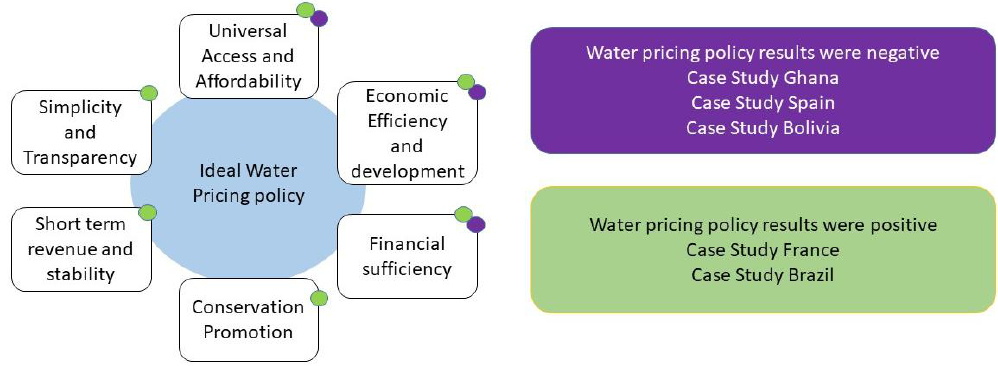
Figure 5. Prioritizing strategies lead to affect positively and negatively water pricing.